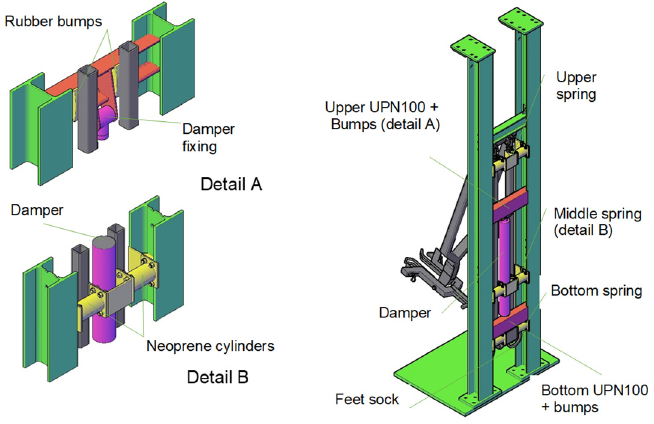
Figure 2. Shock-absorber system and chair fixations to the shelter structure. The viscous damper is installed between the chair’s structure (bottom